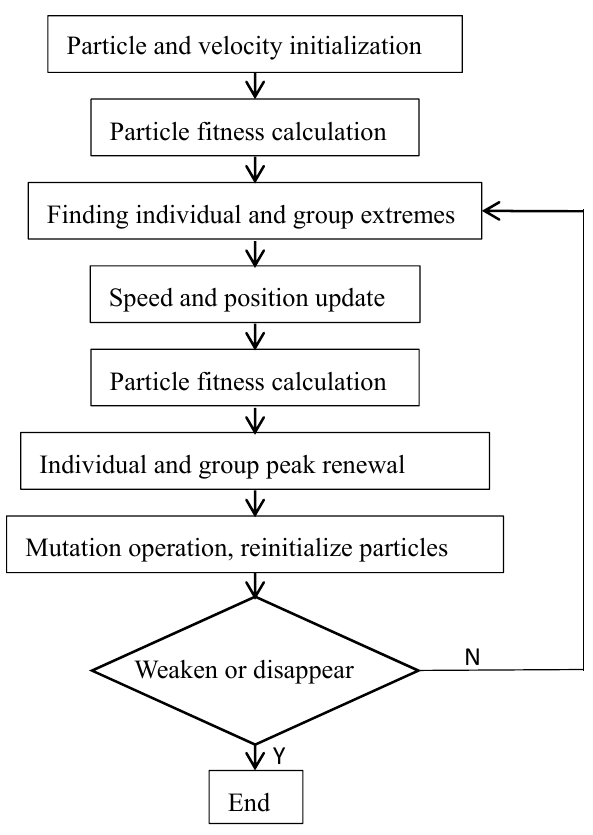
Figure 3. Flow chart of PSO algorithm for adaptive mutation.